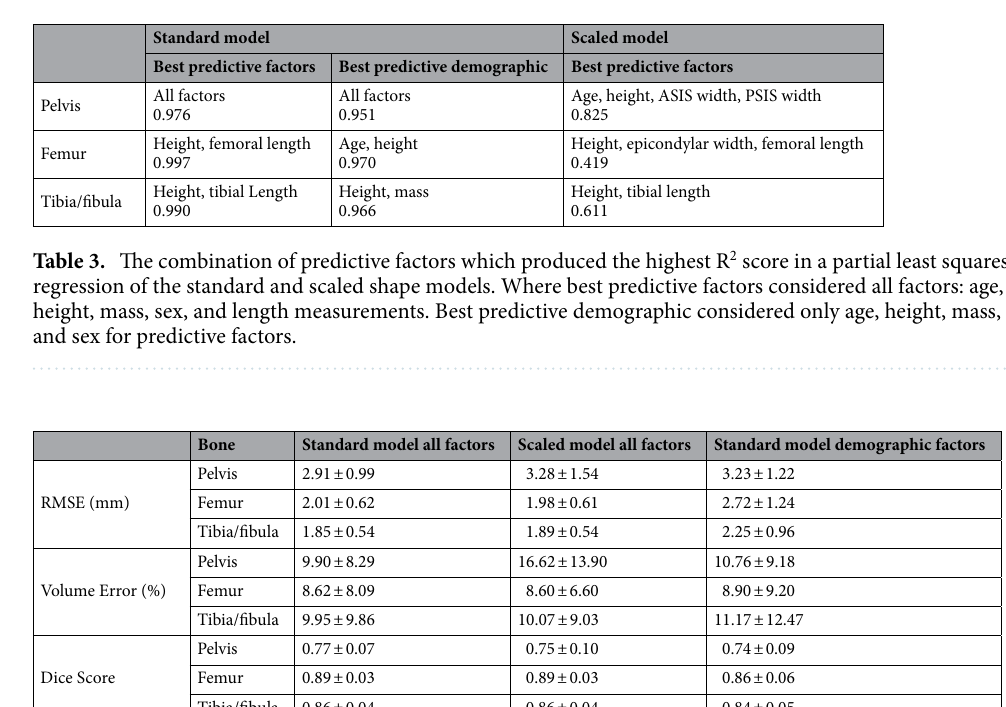
width, and femoral length. And for the tibia/fibula these were height and tibial length. Using only demographic measurements for prediction can be disregarded as this model requires length measurements as input for scaling. Leave one out analysis. The RMSE was lower in the standard shape model when length measurements were included, however the errors were still low when only demographic measurements were available (Table 4). When comparing between the standard shape model and the scaled shape model, the scaled shape model showed higher errors in the pelvis and similar errors for the femur and tibia/fibula. The same conclusions were found when looking at the volume errors and the dice scores. Further comparison of the standard shape model to the scaled shape model showed a larger range of values for the pelvis in the scaled model (Fig. 3). For the femur, the two models were similar. In the tibia/fibula, the scaled model gave a slightly lower spread of values. The scaled model had no added benefit over the standard shape model, and performed worse in the pelvis, therefore, the standard shape model was chosen as our final model.